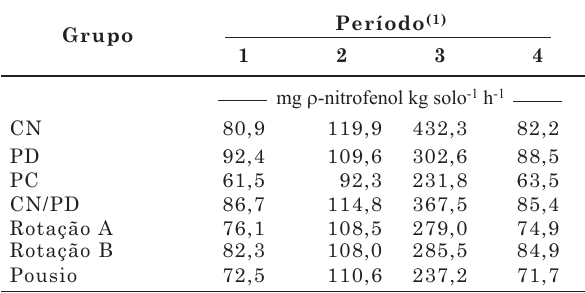
Quadro 9. Médias dos grupos avaliados nos con- trastes ortogonais para valores de atividade da enzima fosfatase ácida